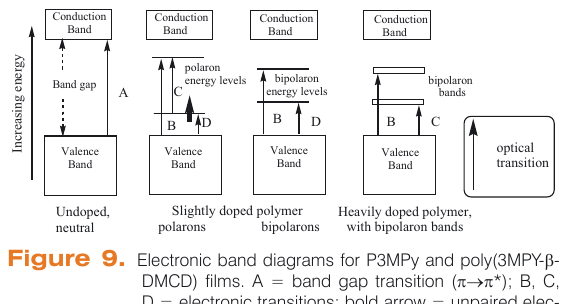
Figure 9. Electronic band diagrams for P3MPy and poly(3MPY- β - DMCD) films. A = band gap transition ( π→π *); B, C, D = electronic transitions; bold arrow = unpaired elec- tron, semi-occupied